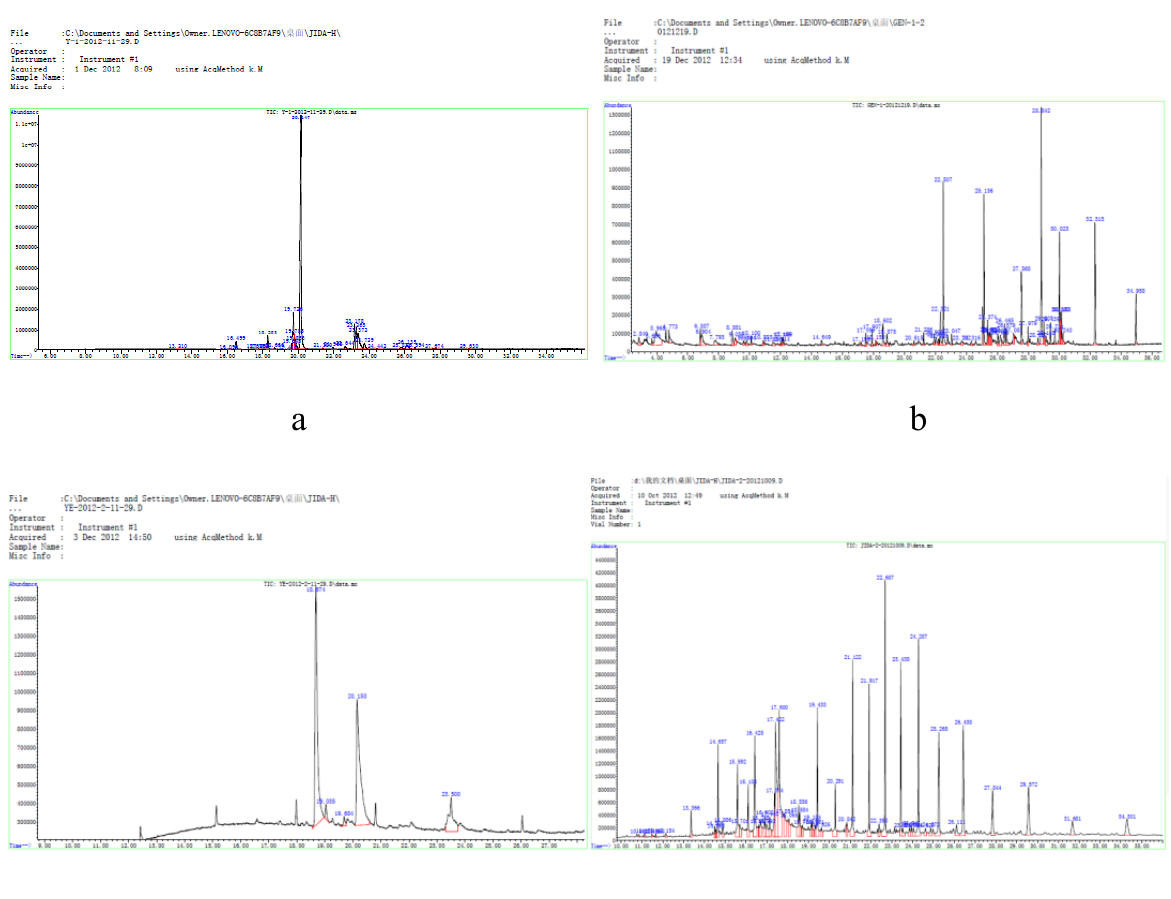
Figure 1: GC-MS chromatograms showed the essential oil in every part of Arisaema amurenseMaxim: (a) Fruits, (b) Tubers, (c) leaves, (d) Petioles.